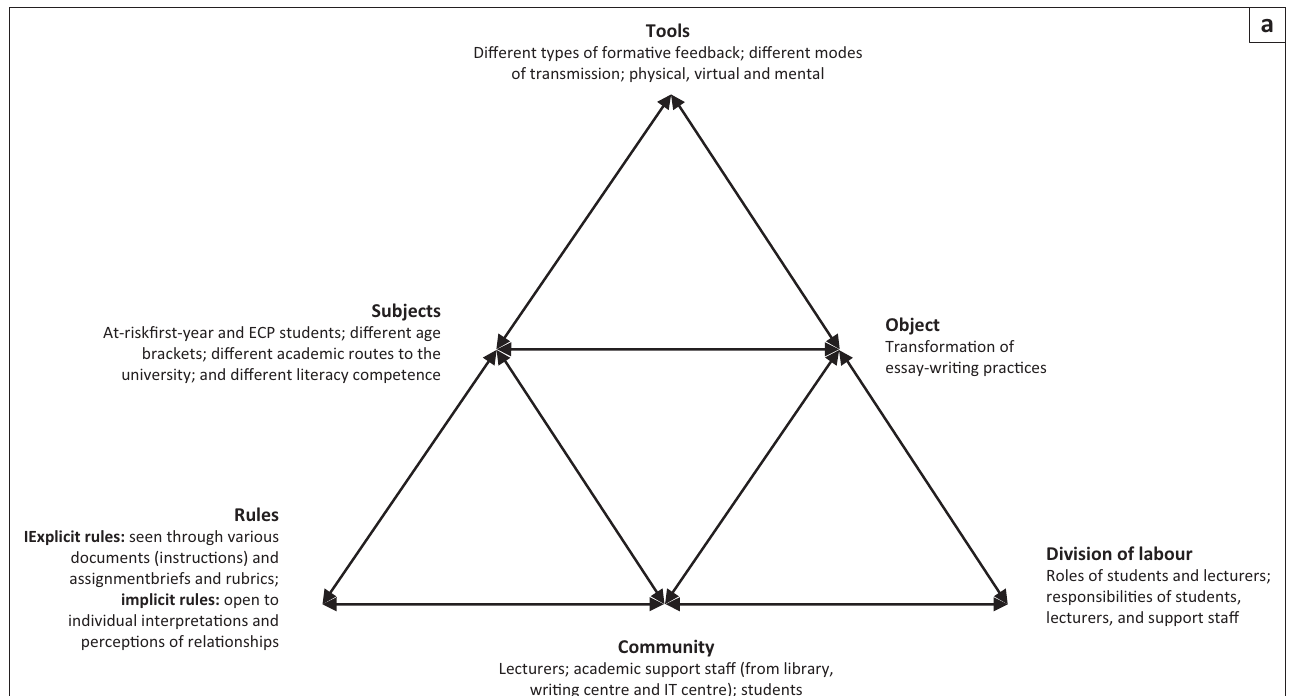
FIGURE 5: (a) The main activity system; (b) Section of activity system where transition causes